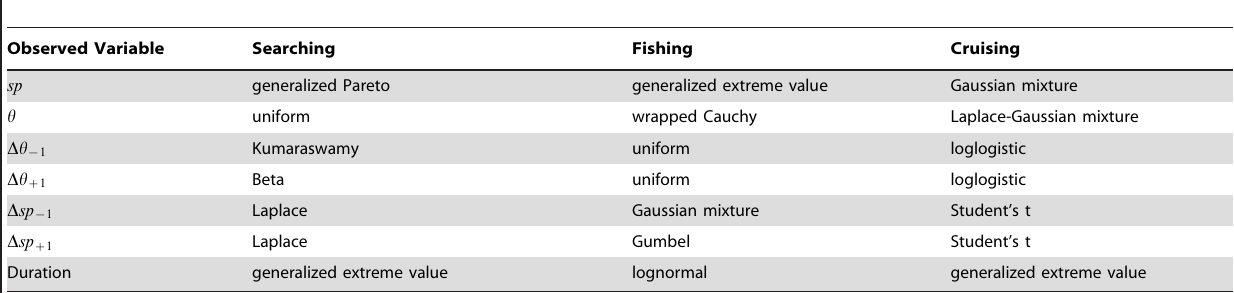
Table 2. Distributions for each observed variable and duration conditioned on